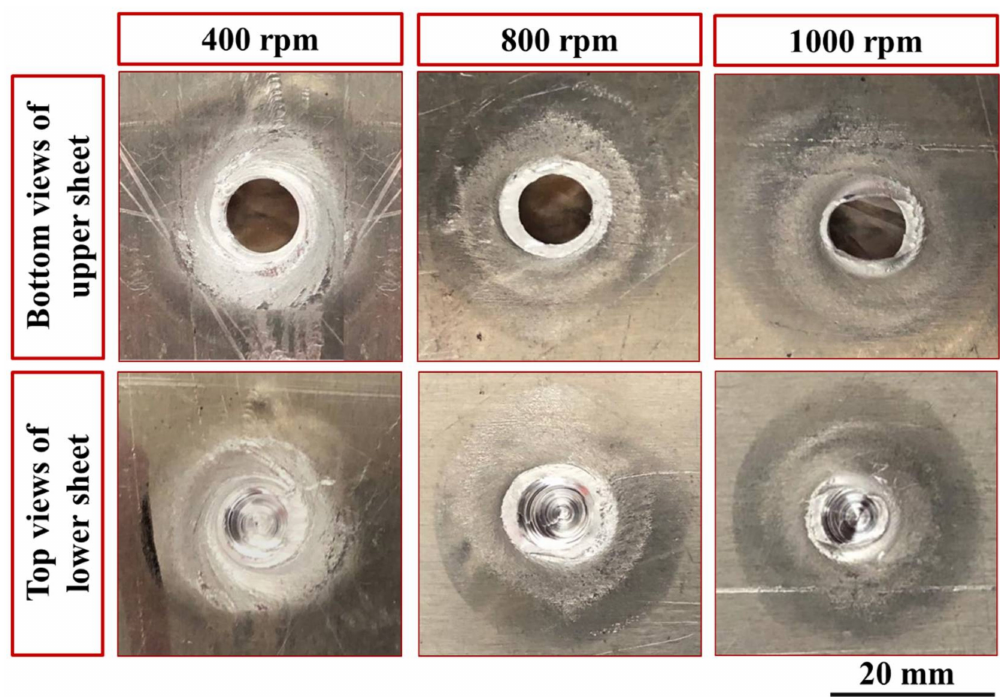
Figure 19. Photographs of fracture surface appearance of the FSSW lap joints processed at 400, 800, and 1000 rpm and 3 s dwell time.